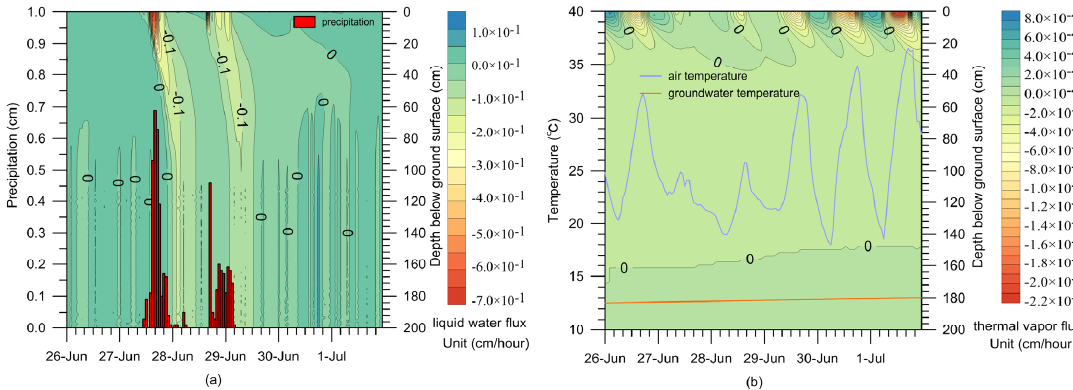
Figure 10. Simulated vertical distribution of the isothermal and thermal liquid water and water vapor fluxes during a typical period from the experimental period before and after a rainfall event (0:00 26 June to 23:00 1 July); ( a ) liquid water fluxes; ( b ) thermal vapor water